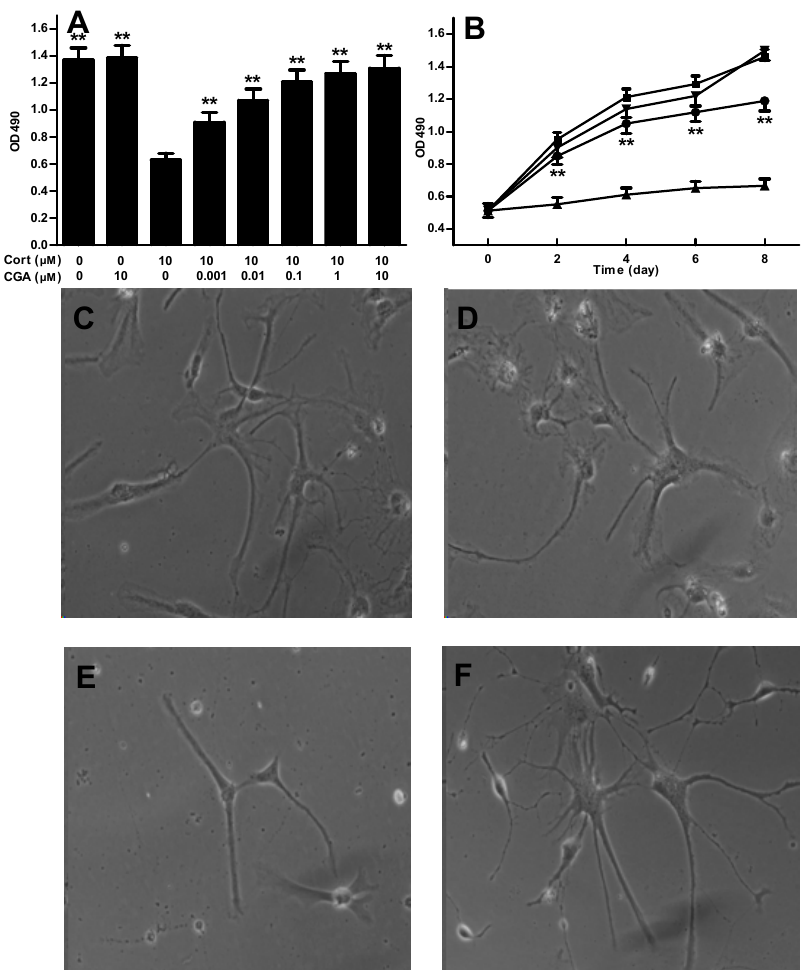
Figure 1. The effects of CGA ± Cort on the cell growth of fetal rat raphe neurons in vitro . ( A ) CGA dose response in protection of Cort-induced cell inhibition, CGA 0.001–10 µM and Cort 10 µM; ( B ) Time response curve of CGA in protection of Cort-induced cell inhibition; Control; CGA 1 nM; Cort 10 µM; and CGA 1 nM + Cort 10 µM; ( C ) A representative image of control showing normal neurons; ( D ) A representative image of CGA (1 nM) treatment showing no neurons damage; ( E ) A representative image of Cort (10 µM) treatment showing Cort-induced neurons damage including cell body atrophy, axon and dendrite loss; ( F ) A representative image of co-treatment of CGA (1 nM) and Cort (10 µM) showing prevention of Cort-induced neurons damage by CGA. The control cells were treated with culture medium with 0.1% DMSO. The results are representative of at least three independent experiments run in triplicate and expressed as the mean ± SD. ** p < 0.01 vs. Cort treatment.